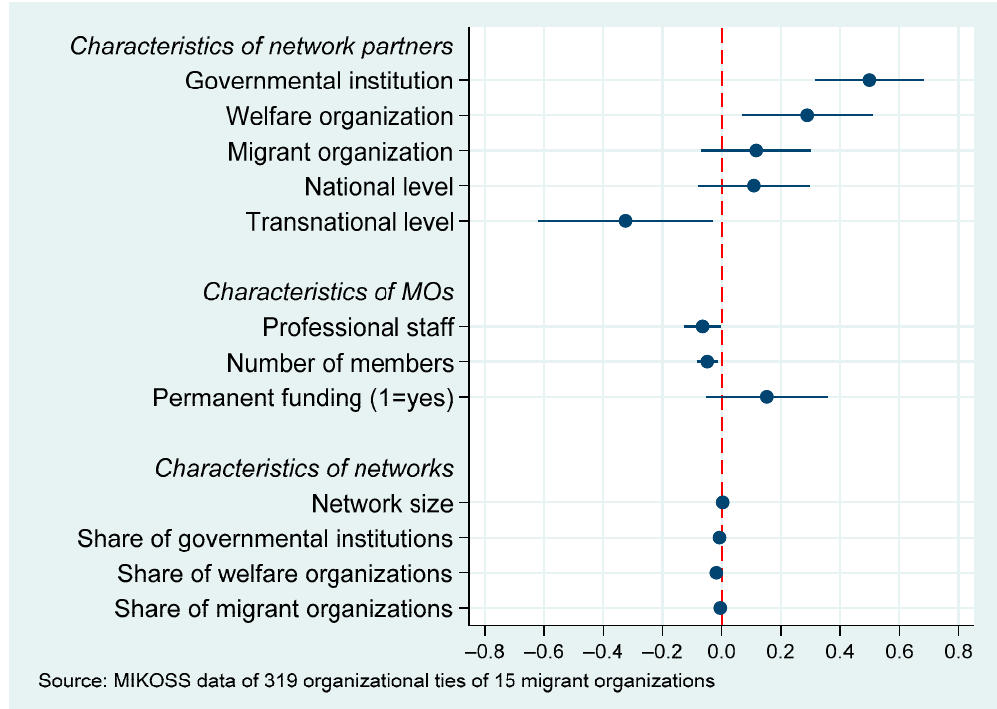
Figure 2. Plot of the coefficient results of the multilevel regression for the relevance of network ties.